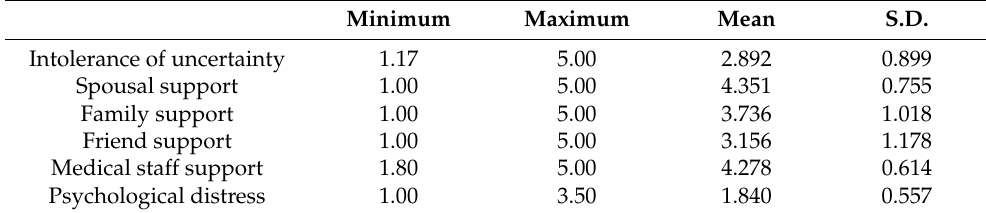
Table 1. Ranges, mean scores and standard deviations of the study variables.